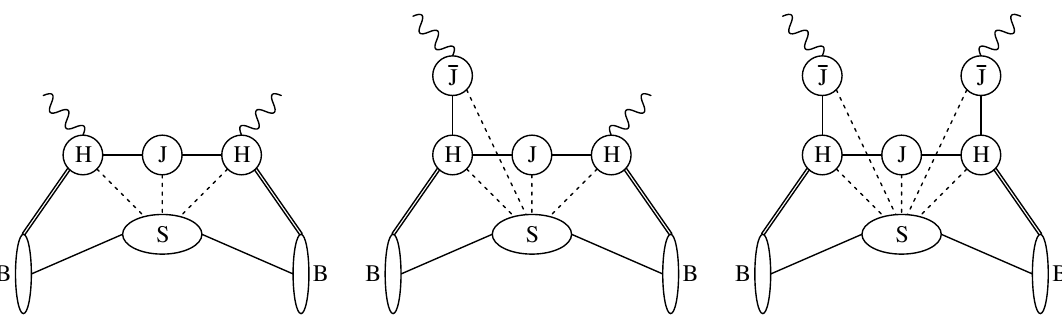
Figure 3 . Graphical illustration of the three terms in the QCD factorization theorem (2.7). The dashed lines represent soft interactions, which must be power expanded and factored o(cid:11) the re- maining building blocks to derive